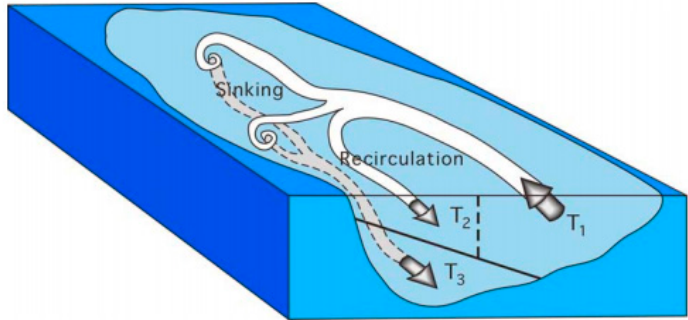
Figure 2. Schematic of circulation through the Strait of Hormuz (Figure 11 of [7]).